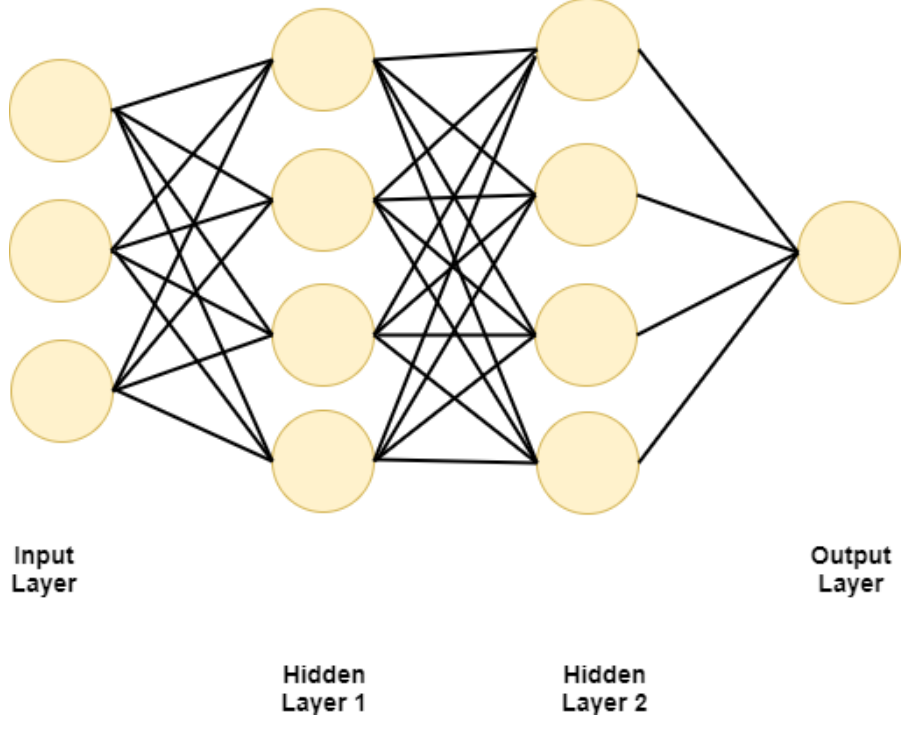
Figure 1. AI task graph as an